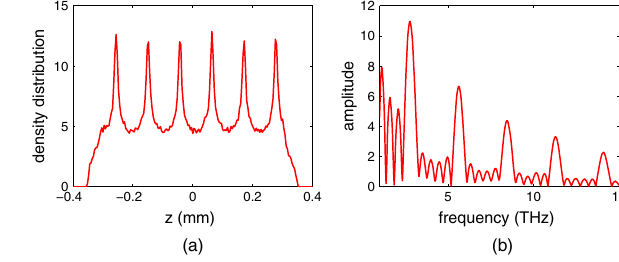
FIG. 4. Bunching factor and central frequency (THz) of density modulation vs R 56 of each dispersion. (a) Bunching factor vs R 56 of each dispersion. (b) Central frequency of density modulation vs R 56 of each dispersion.